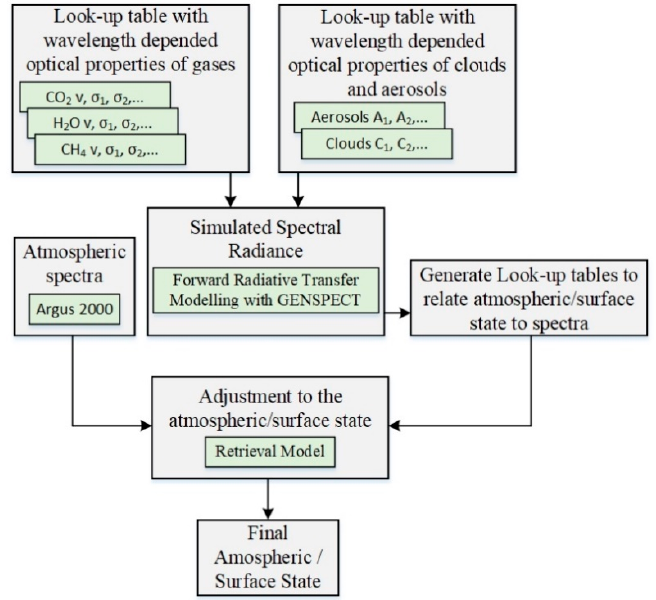
/ surface state retrieval Figure 13. Atmospheric/surface state retrieval algorithm. Figure 13. Atmospheric